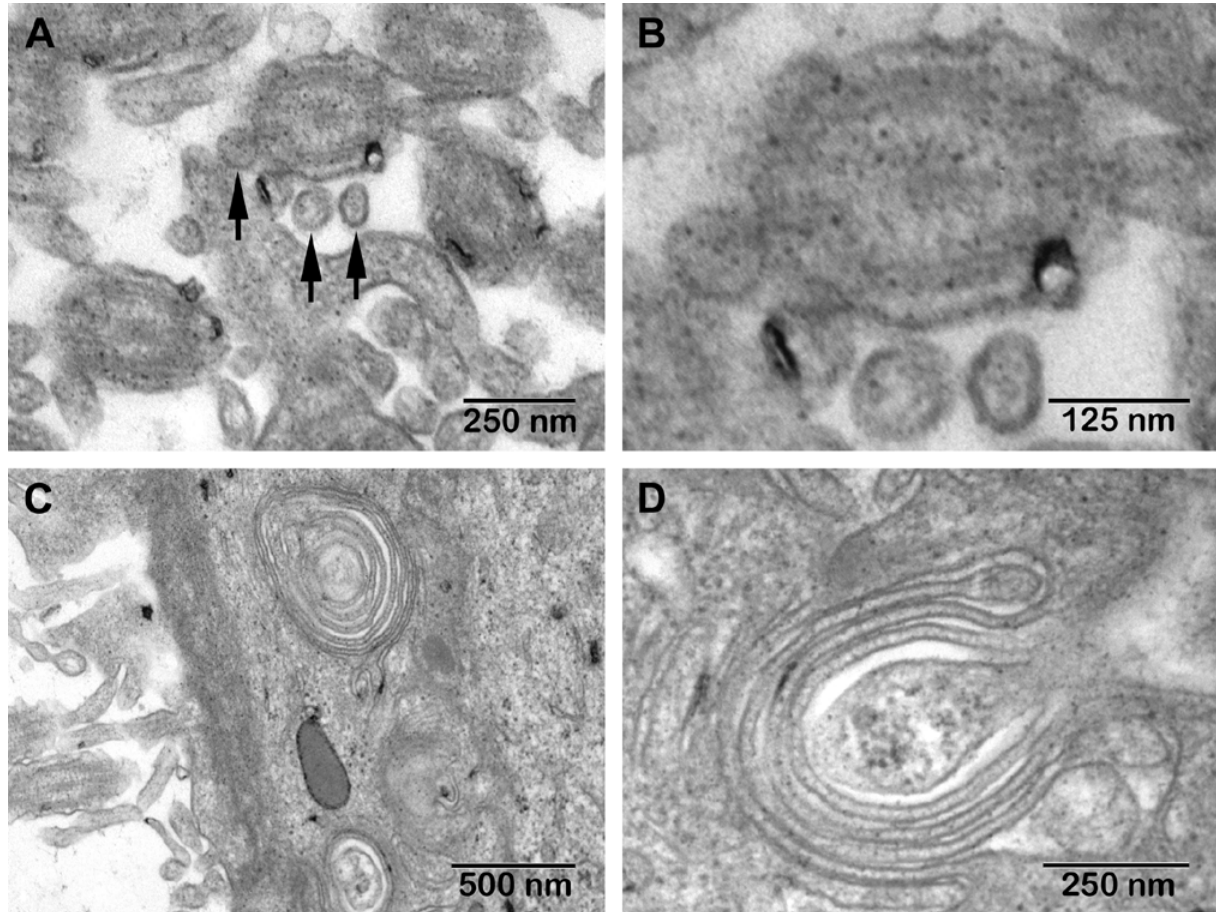
Figure 8. Transmission electron microscopy aspects of COVID-19 nasal mucosa: ( A )—structures suggestive of the SARS-CoV-2 virus; ( B )—detail of ( A ); ( C , D )—multiple Golgi apparatus in epithelial cells.